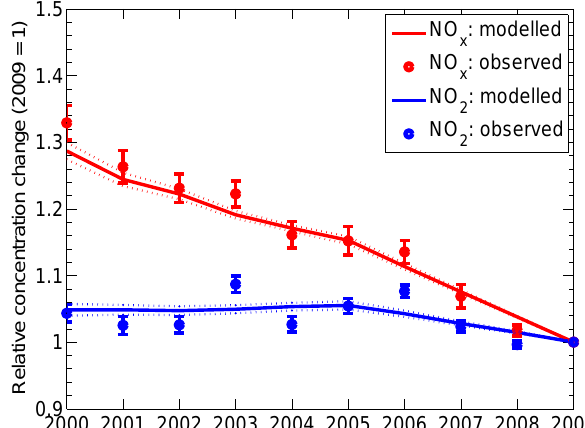
Fig. 8. Trends in NO 2 and NO x concentrations measured and mod- elled at AirBase traffic stations, averaged for the whole EU. Only stations covering at least 9 out of the 10yr are included. Concen- trations are normalised to the year 2009. Standard deviations of the mean are shown as error bars for the observations and as dotted lines around modelled